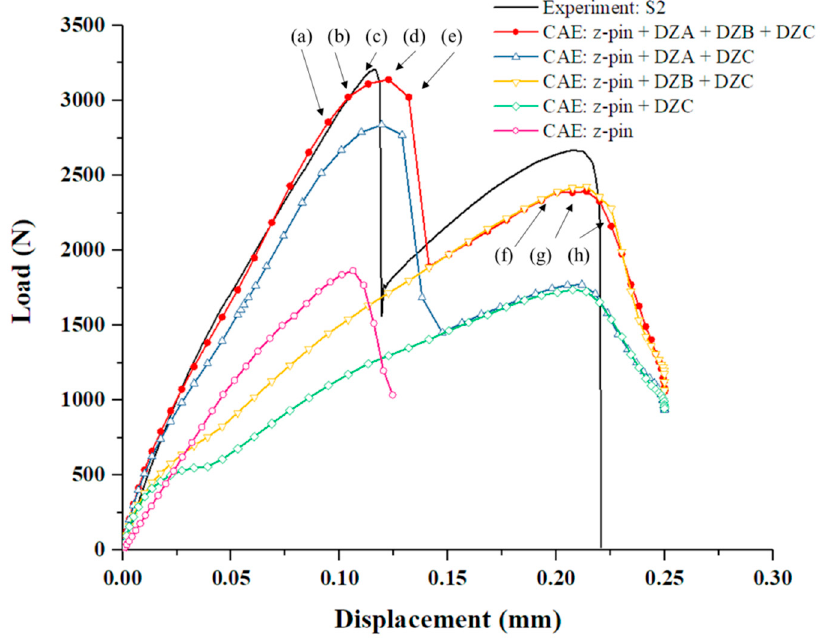
Figure 10. Load–displacement curves of the numerical results with different SiC deposition zones. (Point (a)–(h) represent the key moments of the failure process, and are explained in Section 4.2.).